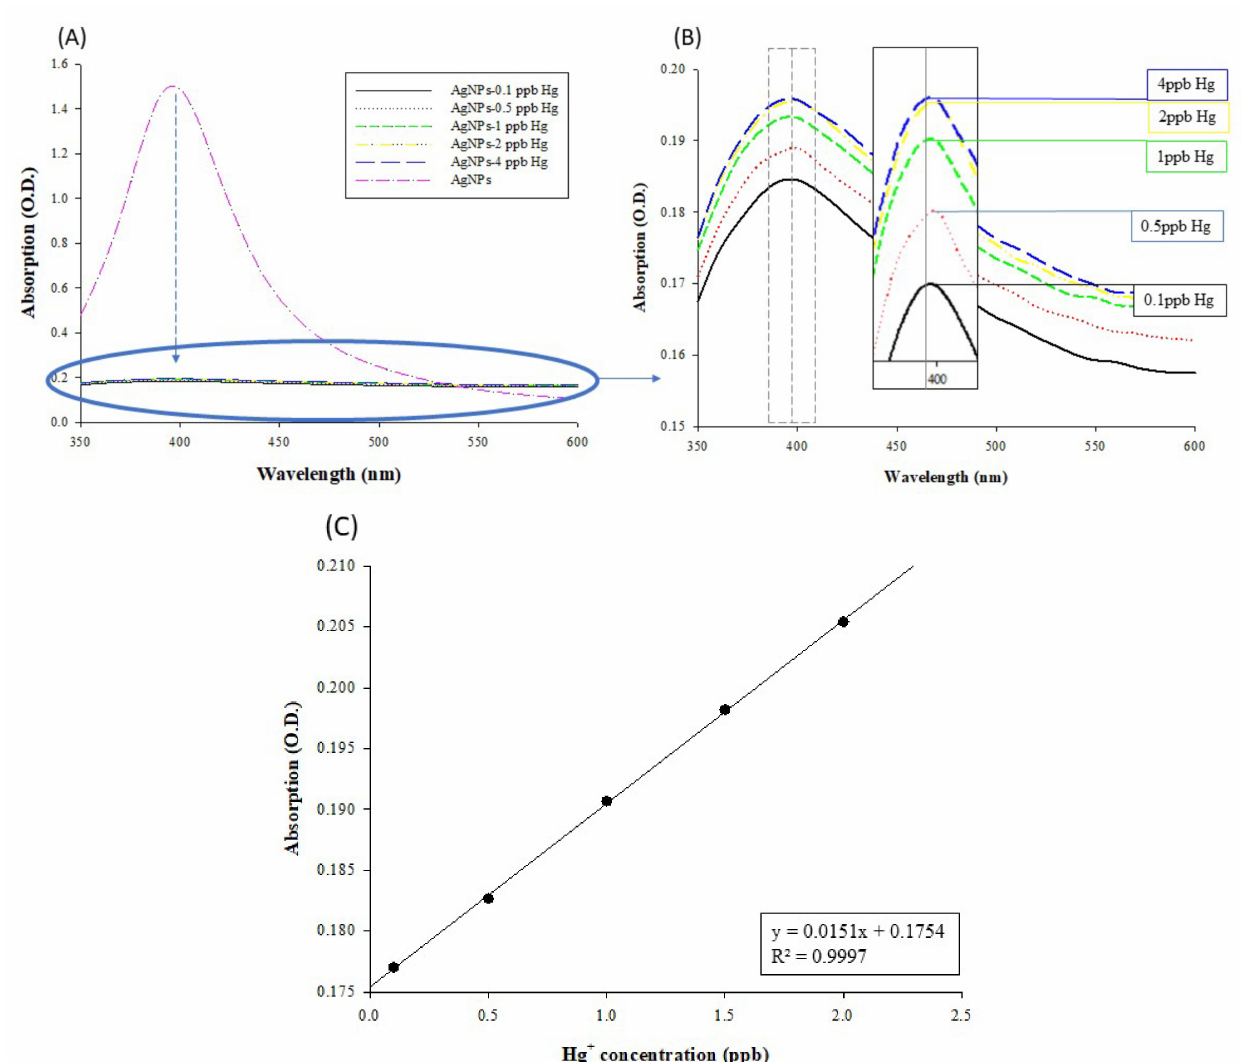
Figure 7. Establishment of the calibration curve for AgNP-based mercury detection: ( A ) UV–Vis absorption spectrum of the